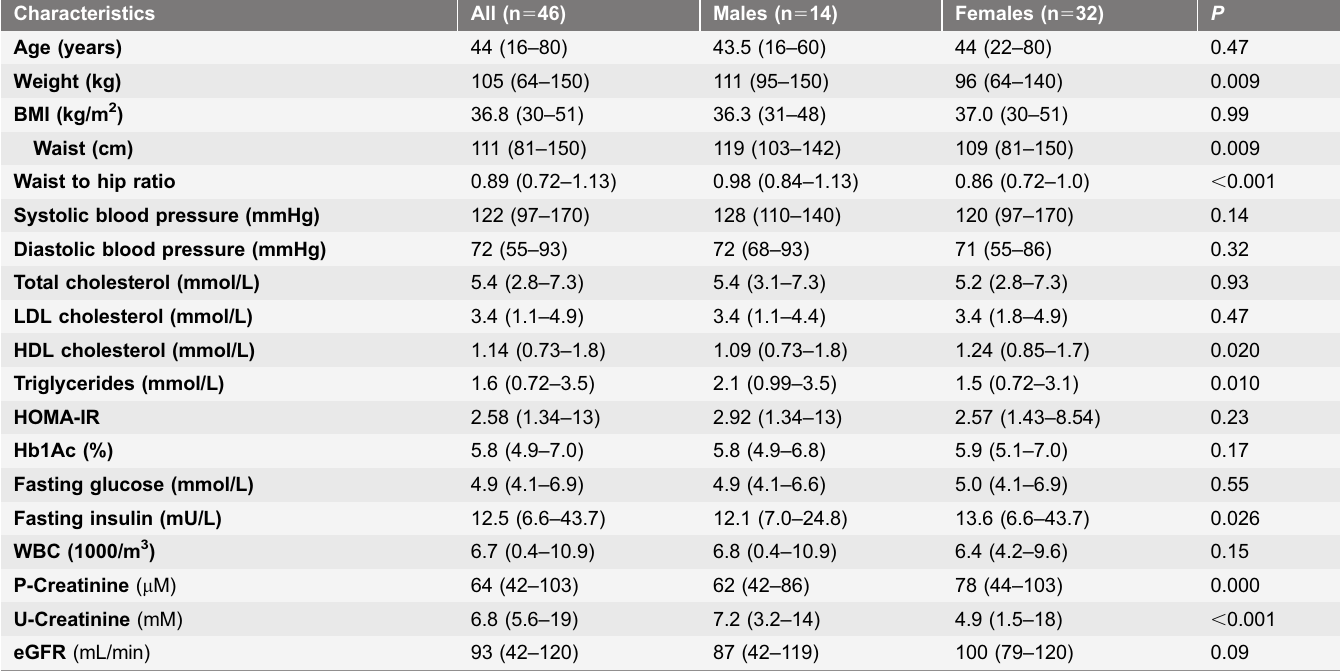
Data are expressed as median (range).